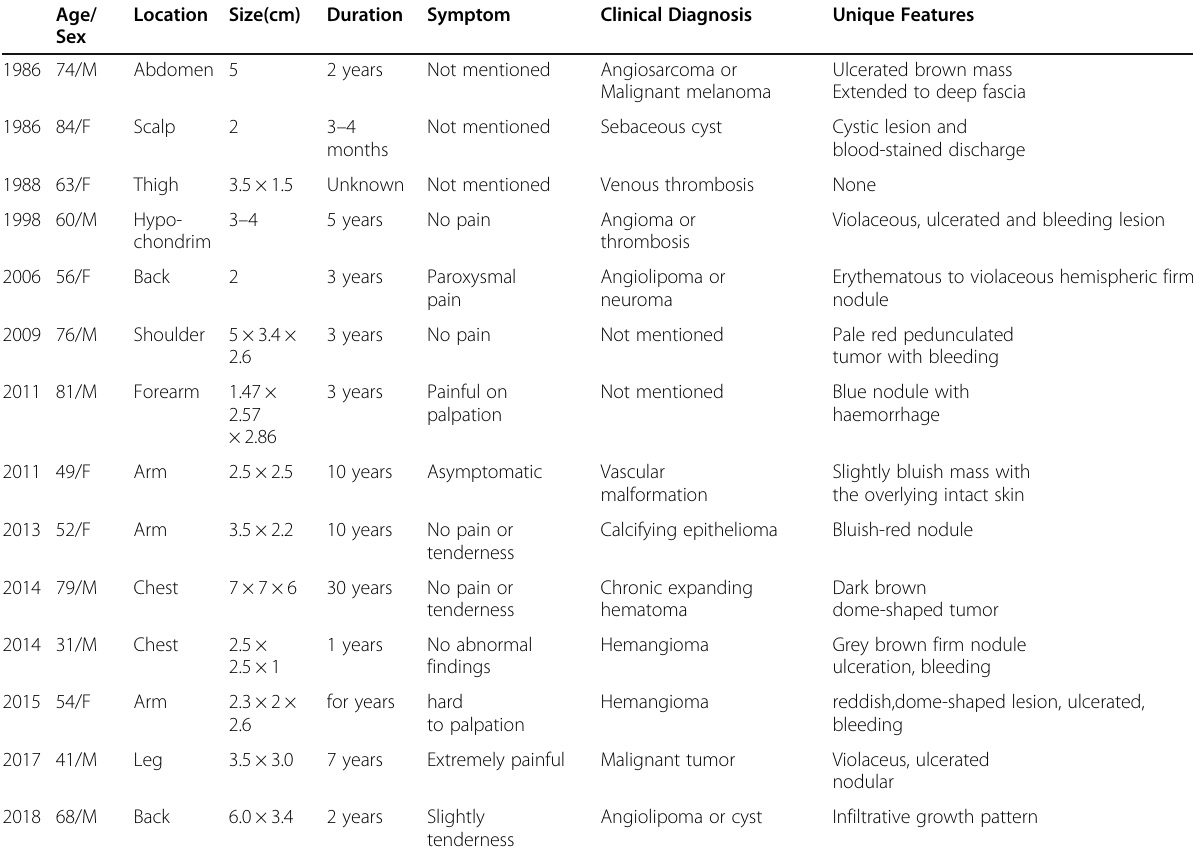
Table 1 Summary of cases of giant vascular eccrine spiradenoma Age/ Location Size(cm) Duration Symptom Clinical Diagnosis Unique Sex